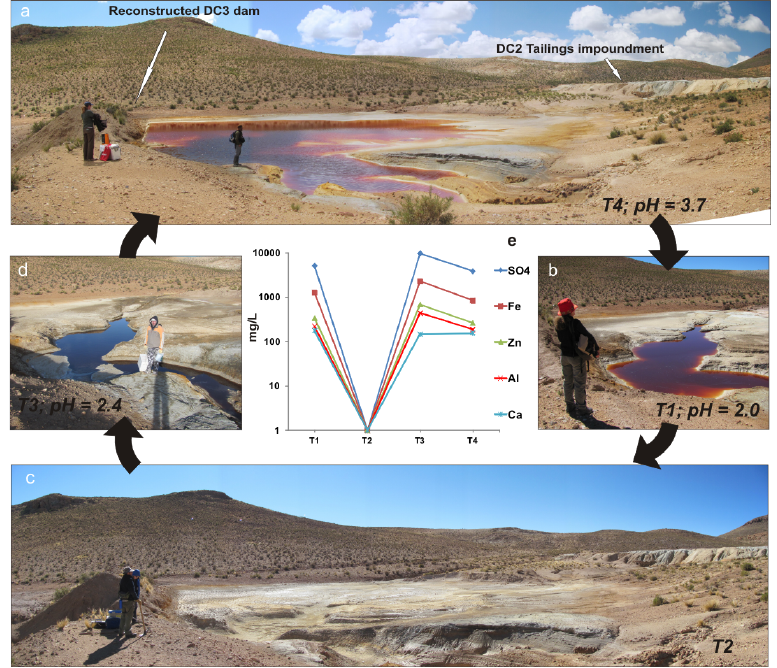
Figure 4. The acid pond on the surface of the tailings impoundments at the Pan de Azúcar mine during the wet and dry seasons. ( a ) T4, end of wet season = sample DC3-L-3 (T4), pH = 3.7; ( b ) T1, during dry season= sample DC3-L-1 (T1), pH = 2.0; ( c ) T2 = lake dried at the end of dry season, pH measurement was not possible; ( d ) T3, beginning of wet season = sample DC3-L-2 (T3), pH = 2.4; and ( e ) Concentration of sulfate and metals (mg/L) for the different periods, scale is